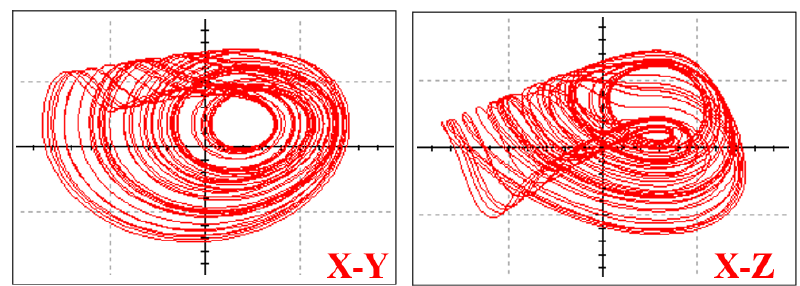
Figure 11. Chaotic attractor in the system (8) from circuit simulation.